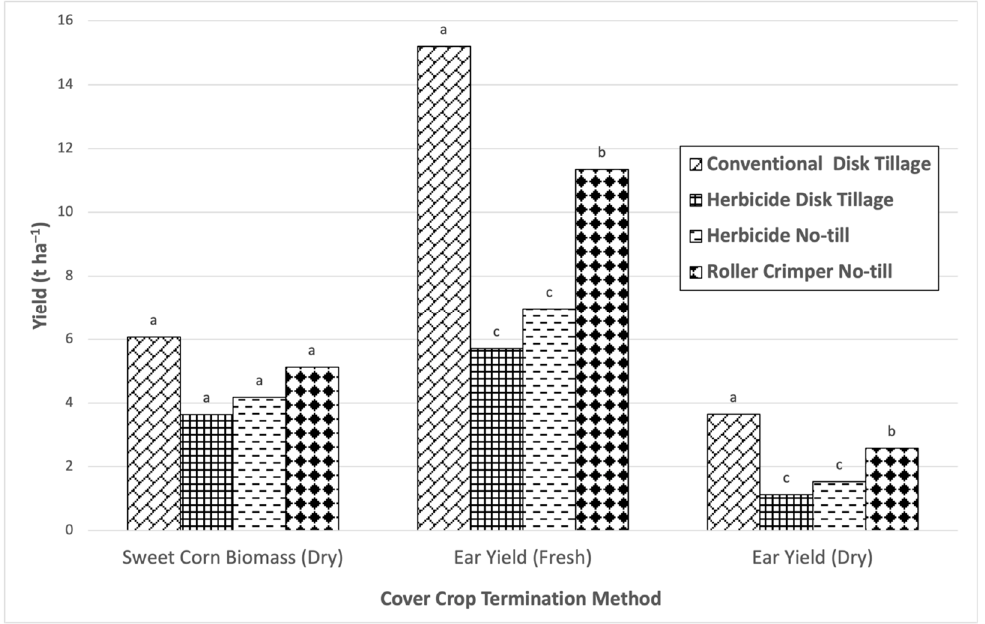
Figure 7. Mean dry sweet corn biomass and ear yield as a function of cover crop termination method in 2021. For each response variable, columns marked with the same letter are not significantly different from each other according to Tukey’s HSD adjusted t tests at p ≤ 0.05.